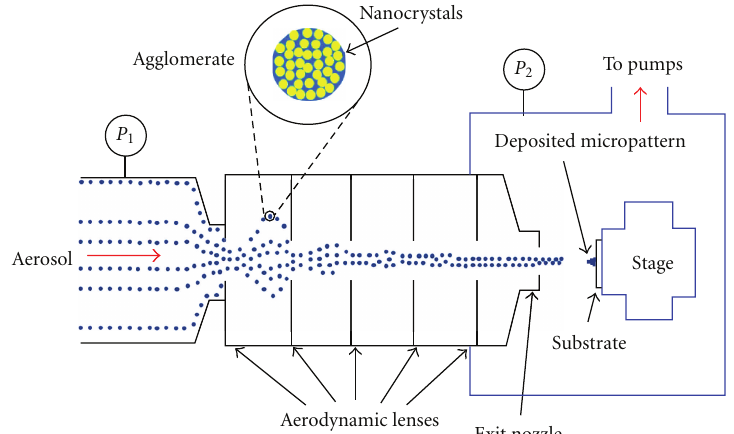
Figure 5: Schematic of A-DW focused particle beam deposition system, from Qi et al. [15], Aerosol Science and Technology, Copyright 2010, Mount Laurel, NJ. Reprinted with permission.